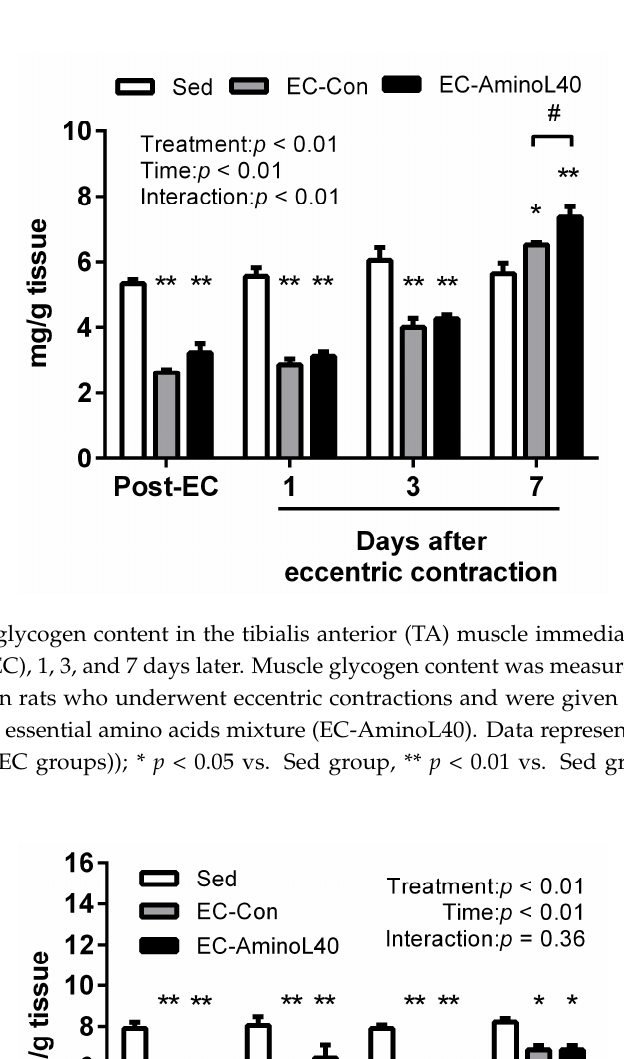
Figure 2. Adenosine tri-phosphate (ATP) content in the tibialis anterior (TA) muscle immediately after eccentric contraction (Post-EC), 1, 3, and 7 days later. ATP was measured in the sedentary group (Sed), and in rats who underwent eccentric contractions and were given water (EC-Con) or a leucine-enriched essential amino acids mixture (EC-AminoL40). Data represent the mean ± SEM ( n = 4 (Sed) or 5 (EC groups)). * and ** p < 0.05 and < 0.01 vs. Sed group at the same time point,